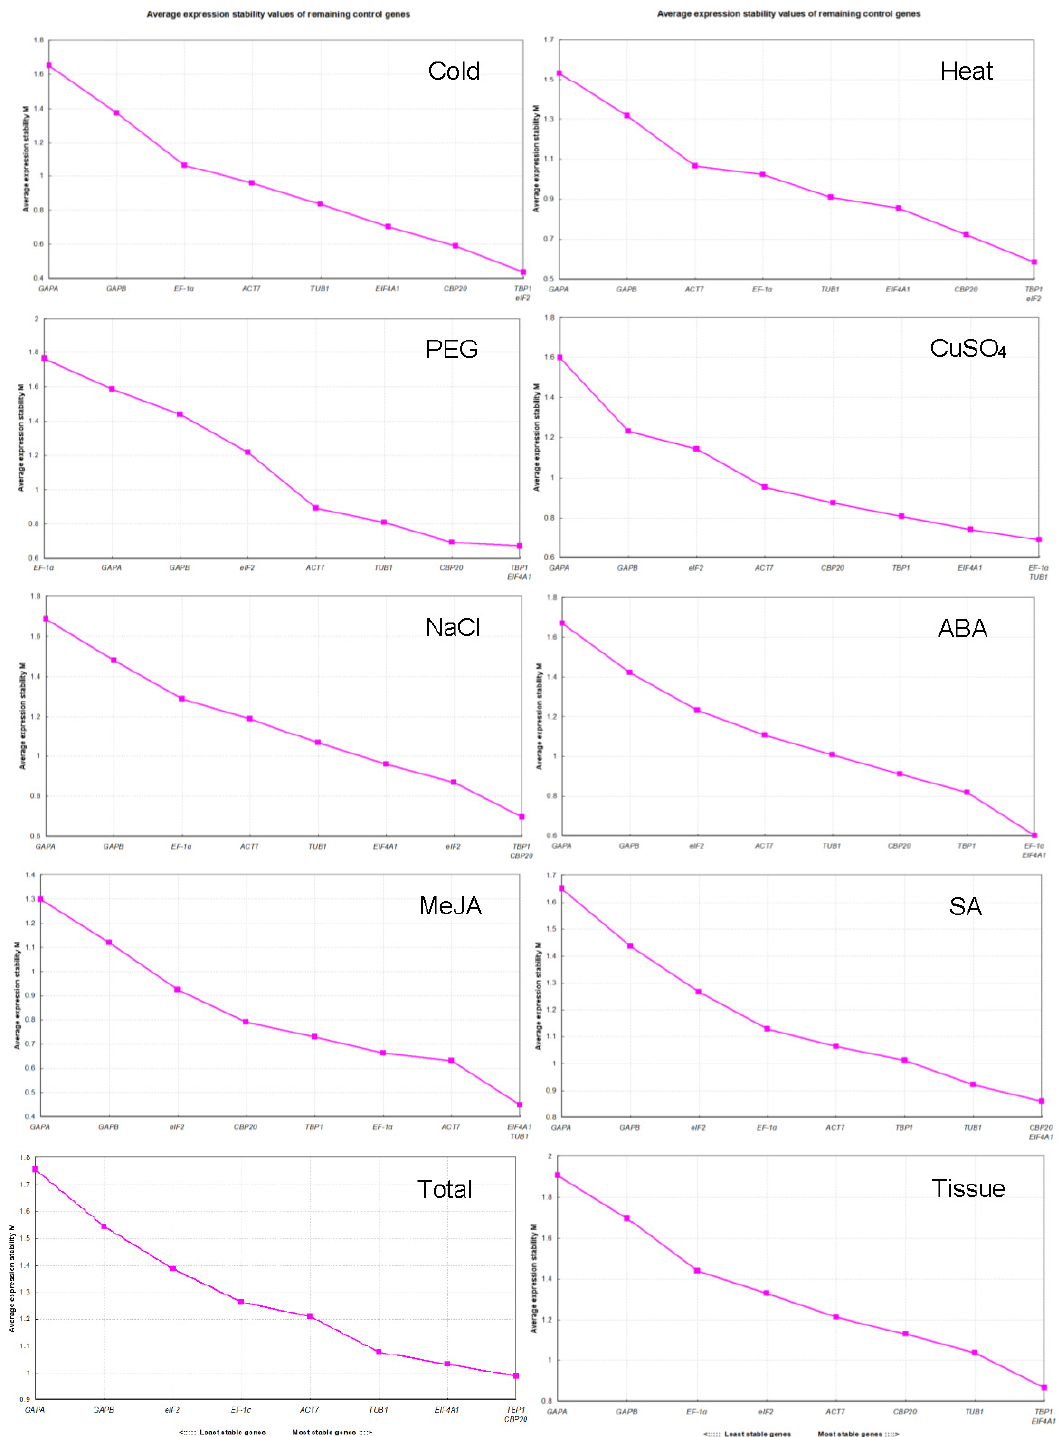
Figure 3. Average expression stability values M of nine candidate reference genes calculated by geNorm with samples from given experimental conditions. The most unstable genes are on the left and the most stable genes are on the right. Cold, Heat, PEG, CuSO 4 , and NaCl represent samples from different abiotic stresses; ABA, MeJA, and SA represent samples from different hormone treatments; Tissue represents samples from roots, stems, and leaves of CK and flowers; Total represents samples from all abiotic stress and hormone treatment groups.